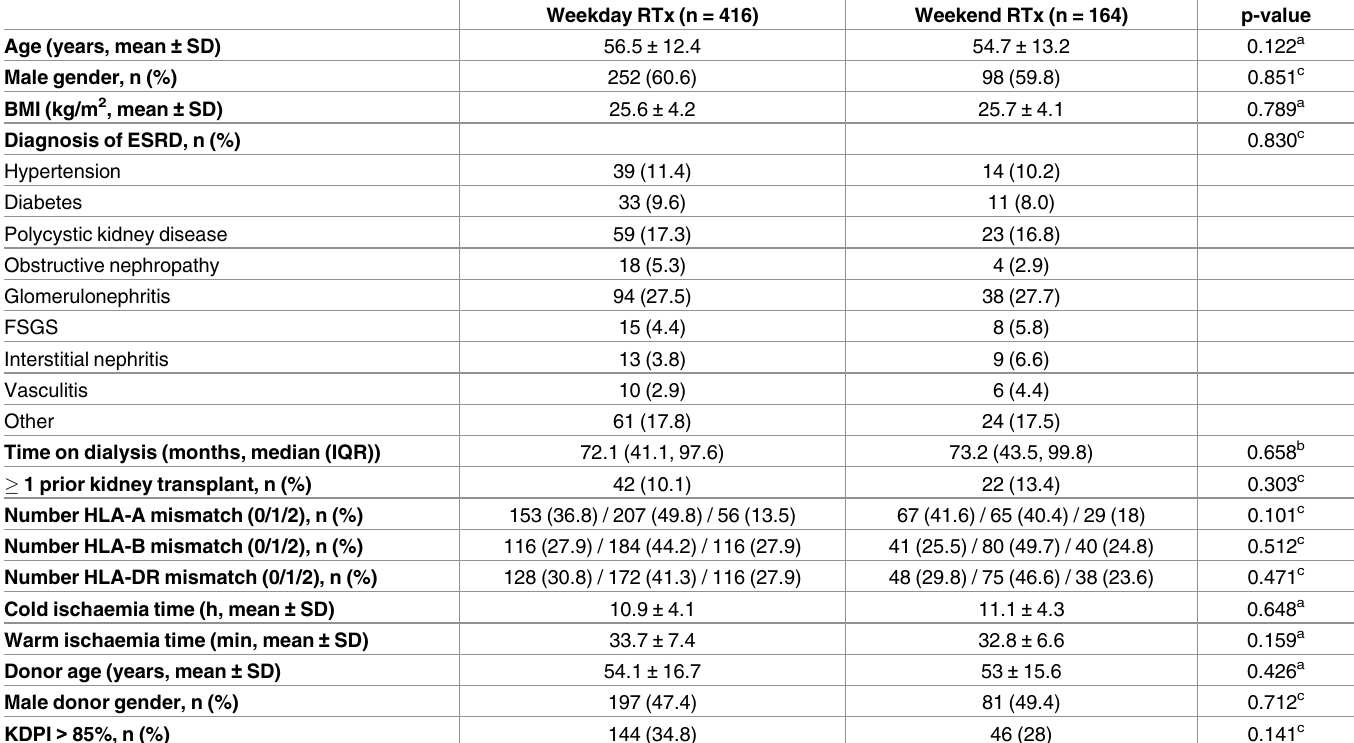
Table 1. Patient